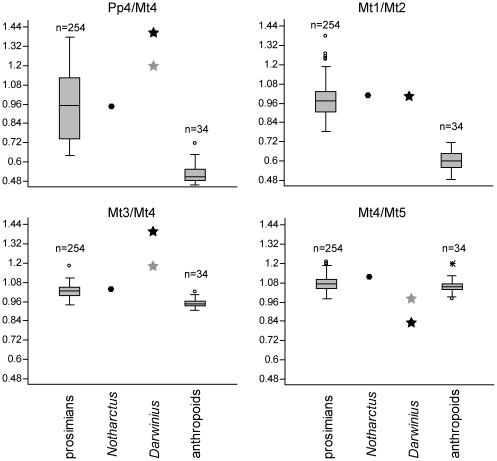
Boxplots of pedal proportions.Abbreviations: Pp, proximal phalanx; Mt, metatarsal. Statistical treatment of their data is given in Table 7. See Materials and Methods for further information.